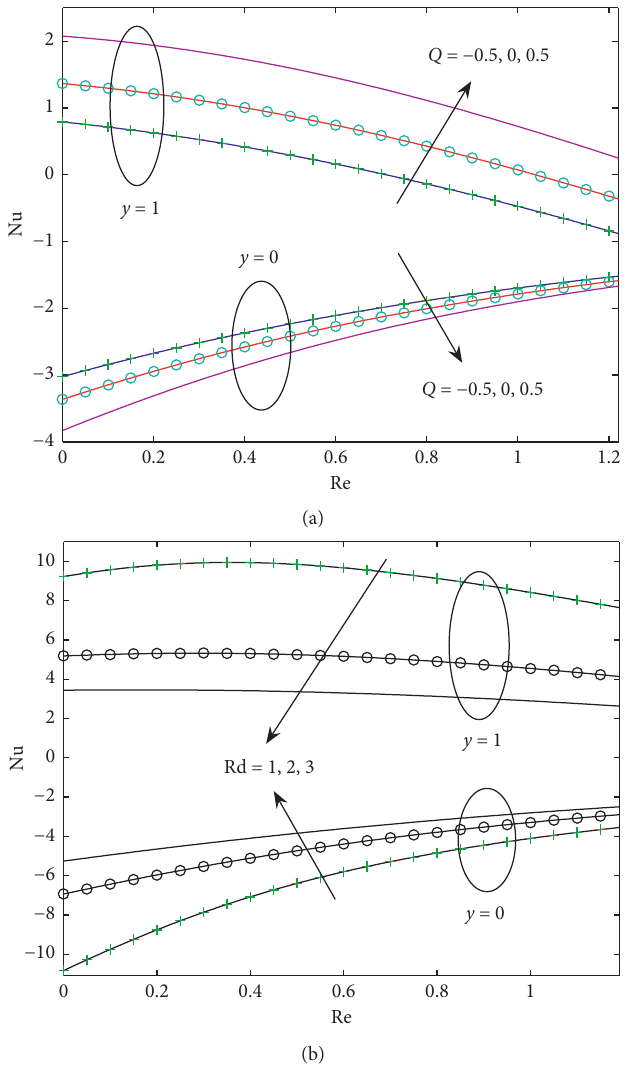
Figure 9: Nusselt number distribution for t � π /4 , ε � 0 . 01 , H � 3 , β � 2 , Ec � 1 , Da � 0 . 1 , M � 0 . 5 , Re � 1 , andPr � 21. (a) Effect of Q when Rd � 2and ϕ � 0 . (b) Effect of Rd when Q � 0 . 5and ϕ � 0 . 1. Table 1: Comparison of the Nusselt number for Newtonian and non-Newtonian fluids with the work of Srinivas et al. [18] for the